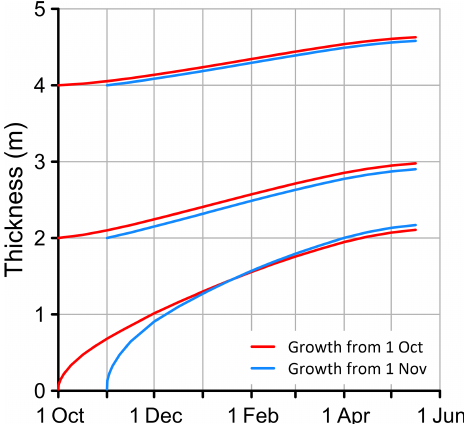
Figure 9. Calculated wintertime growth of sea ice of three initial thicknesses. The air temperature and snow depth on ice that control the growth were averages of 1981–2010 climatological conditions at Resolute Bay and Eureka.